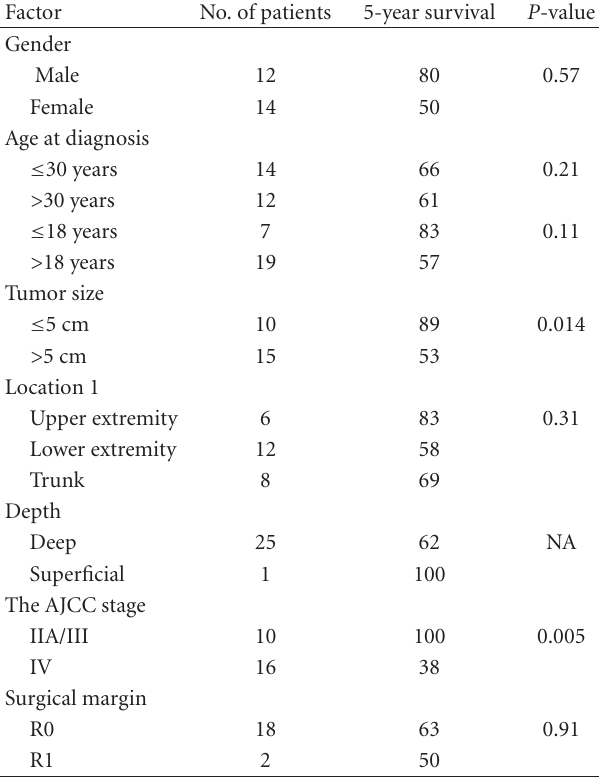
Table 2: Potential risk factors for overall